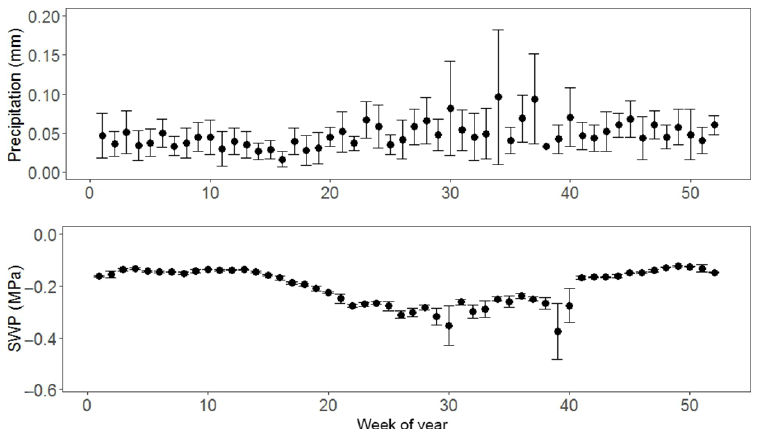
Figure 2. The time series of the weekly total precipitation and mean soil water potential (SWP). The precipitation and SWP data are averaged over the period 1998–2013. The error bars represent the 95% confidence